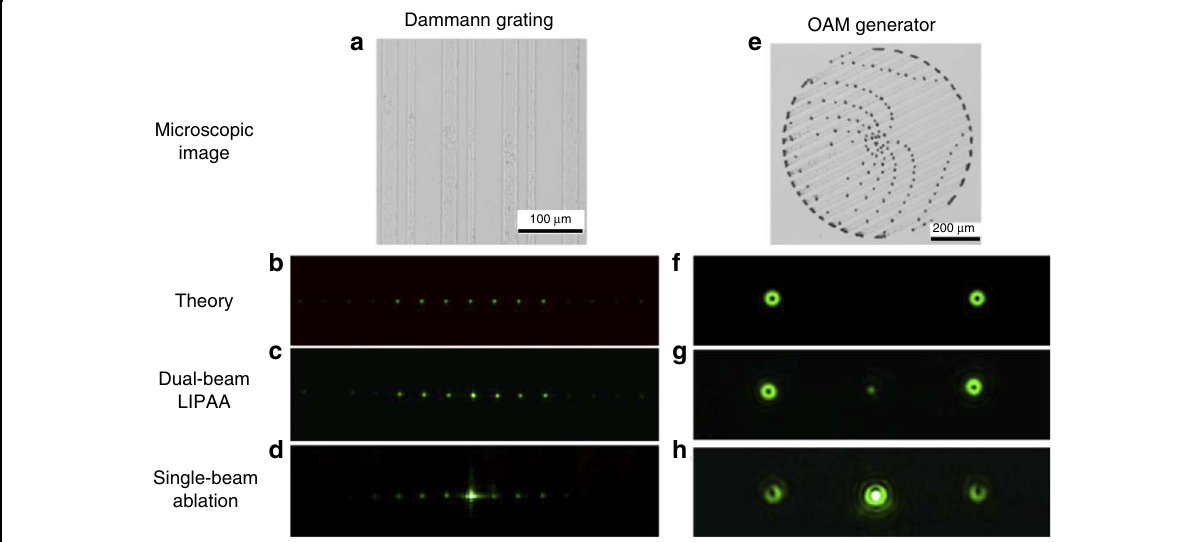
Fig. 7 Optical components fabricated by dual femtosecond laser beam LIPAA. a , e Microscopic images of a Dammann Grating and an OAM generator fabricated on sapphire. b , f Theoretical simulation of the diffraction pattern of the Dammann Grating and OAM generator. c , d Measured diffraction patterns of the Dammann Grating fabricated by dual-beam LIPAA and single-beam femtosecond laser ablation, respectively. g , h Measured diffraction patterns of the OAM generator fabricated by dual-beam LIPAA and single-beam femtosecond laser ablation, respectively 54 . Reproduced with permission from ref. 54 , © 2020 Optical Society of America